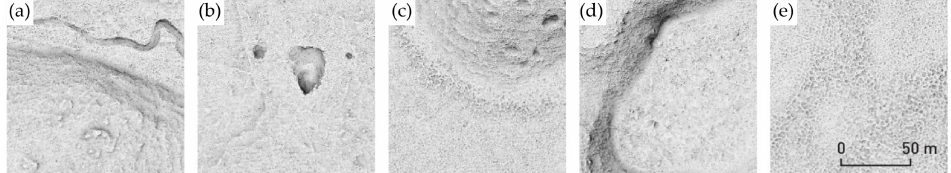
Figure 8. VAT visualizations of generated terrain samples. A hill slope with a stream bed in a flat, narrow valley ( a ), low walls and possible quarries on a lever, raised ground ( b ), a bajo and a steep slope ( c ), a baho and a steep slope with a possible sink hole ( d ), and a bajo ( e ). The scale is